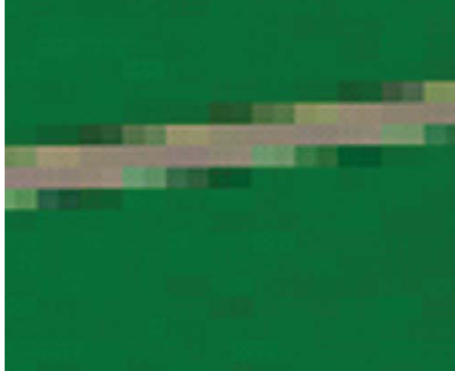
Fig. 2. Colour changes at the edge of white line. Fig. 3. The scanned pixels on the image.